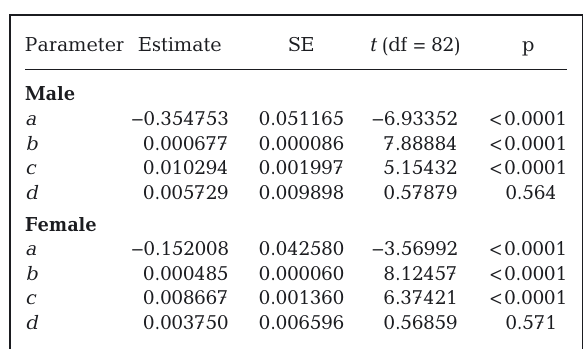
rather than the estimates based on the observed ship between MnM and dpi suggests that the appearance of adults only (Table 2). The values of copepodid stage, the 2 chalimus stages and the 2 the constants of the model MnM (T) = a + (bT 2 + cT preadult stages are all of approximately equal + d) dpi, where rM (T) = bT 2 + cT + d , is given in duration, implying that each of the stages lasts Table 3. The observed and predicted linear rela- about 20% of the total development time to the tionship between MnM and dpi at each of the tem- adult stage. The molt rate (rM) for males and peratures tested is shown in Fig. 2, whereas the females changed with temperature according to a predicted relationship between rM and T is shown pattern best described by a second-order polyno- in Fig. 3. The overall linear nature of the relation- mial (Fig. 3). Table 3. Growth model parameters for male and female Lepeo phtheirus salmonis estimated using nonlinear estima- tion (Statistica). The growth model fitted was MnM = a + ( bT 2 + cT + d) dpi, where MnM is mean number of molts, T is tem- perature, and dpi is days post infection. The model assumes a constant molt rate during development from copepodid to adult at temperature ( T) , and a polynomial relationship be- tween growth rate and T . The constants a, b , c and d were es- timated for each sex and the model was parameterized using data for temperatures from 6 to 21°C. The proportion of vari- ance accounted for by the model was 0.98 for both males and females. The mean molt rate at temperature T is rM( T) = bT 2 + cT + d